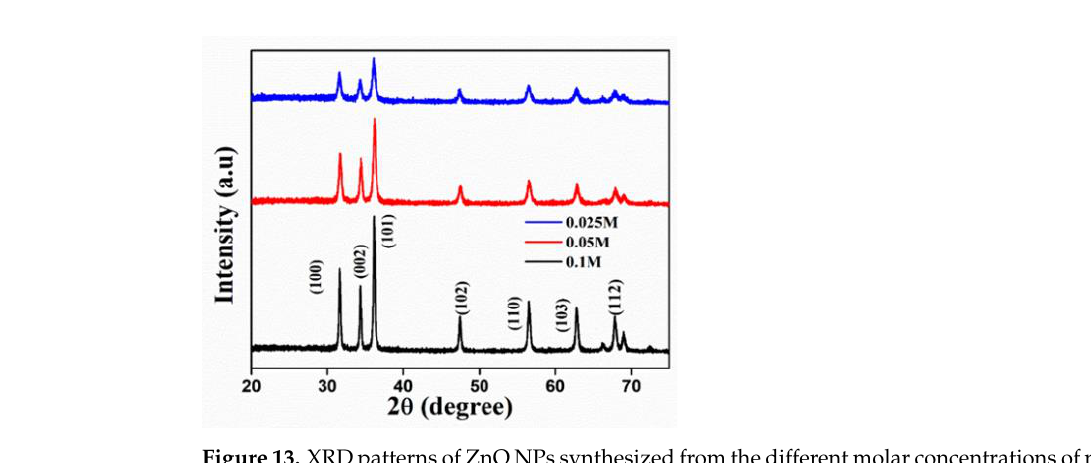
Figure 13. XRD patterns of ZnO NPs synthesized from the different molar concentrations of precursor. Table 2. Crystallite size of ZnO NPs by varying Zn(NO 3 ) 2 concentration. Sl. No.